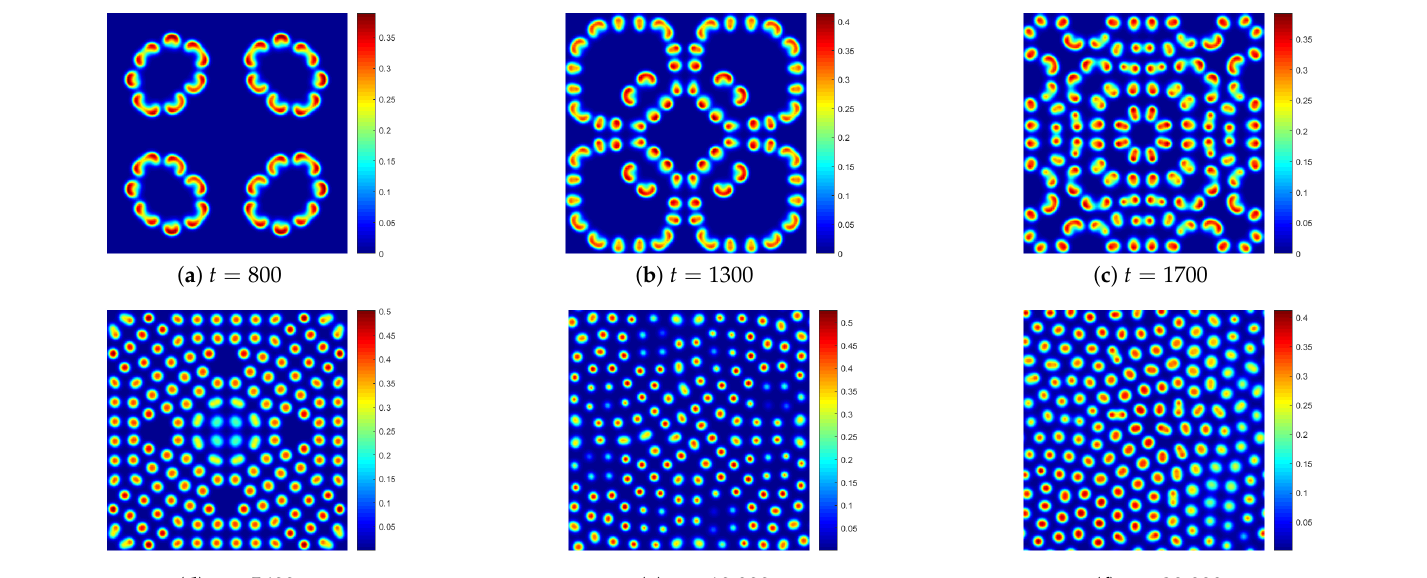
Figure 15. The patterns of u at α = β = 1.9 for Experiment 3 with D u = 2 × 10 − 5 , D v = 1 × 10 − 5 , τ = 0.01. F = 0.037, k = 0.058.